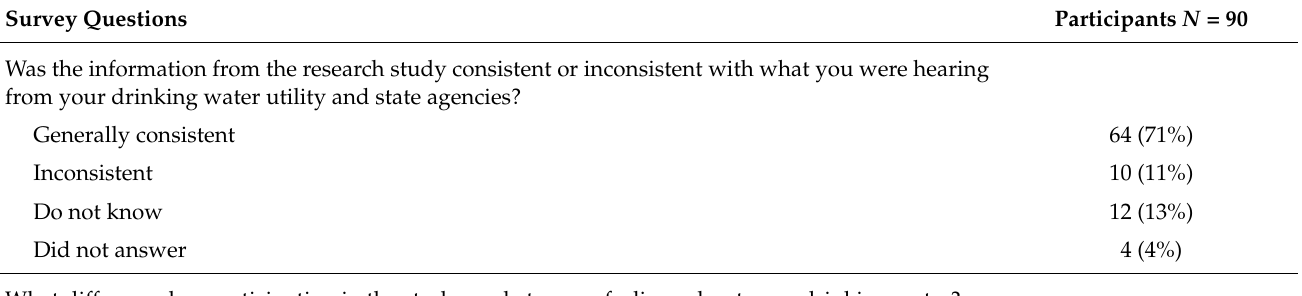
Table 1. Participant responses related to drinking water, Paradise